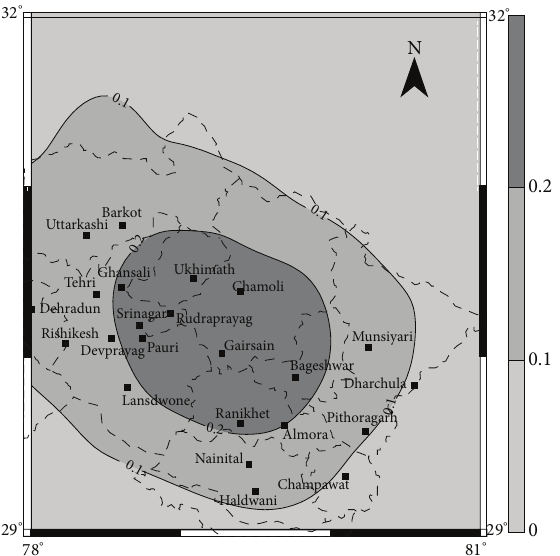
Figure 10: Seismic hazard map showing contours of 10% and 20% probability of exceedence of peak ground acceleration of value 100gals.